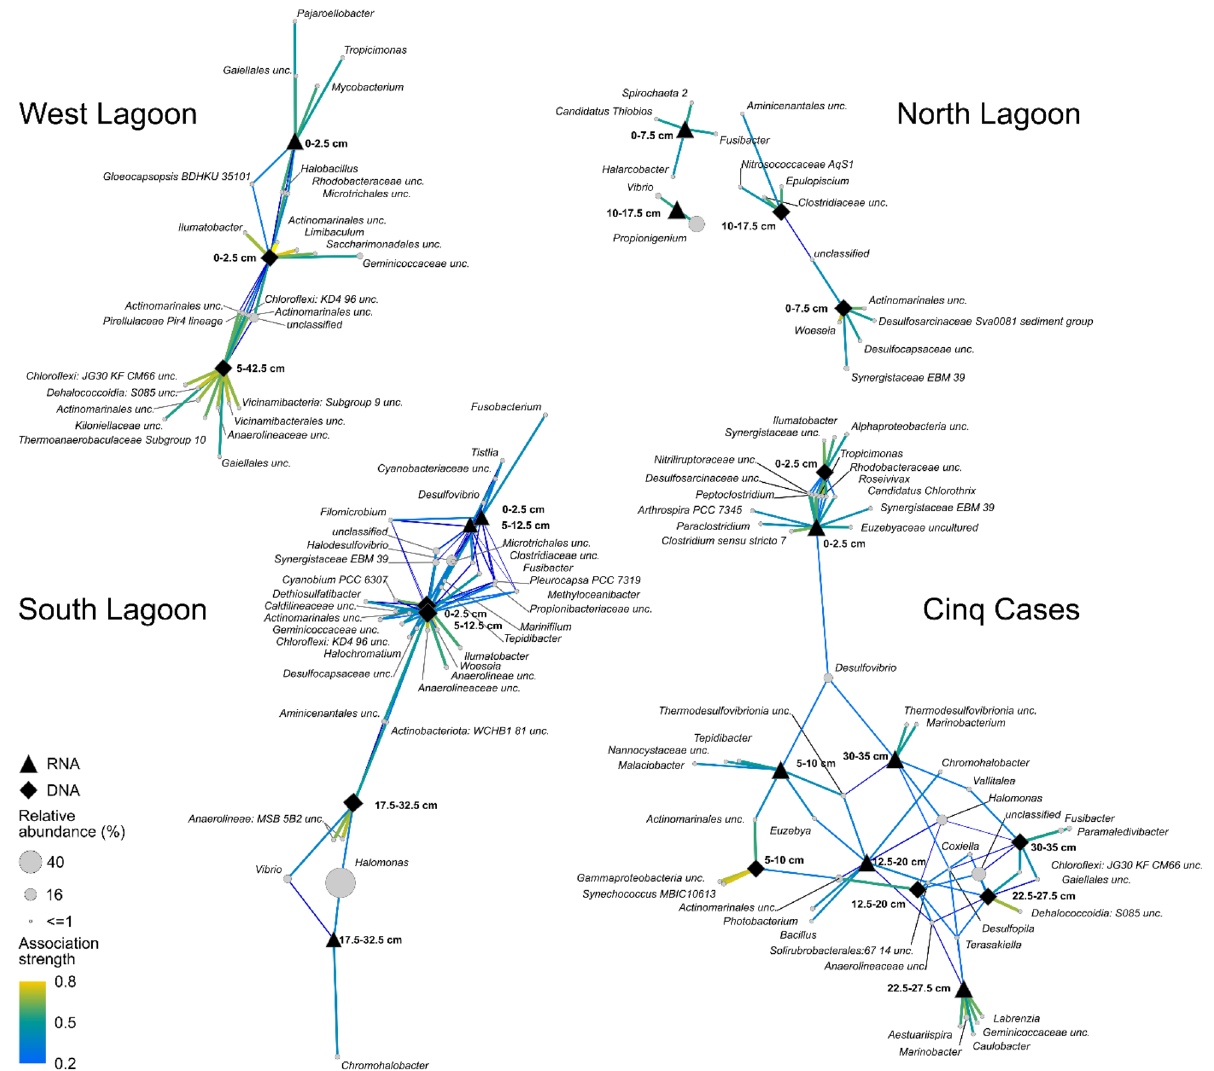
Figure 5. Genera associated with the total or active community fraction at each sampling site based on the geochemical zonation. The network was calculated using the multipatt analysis from the indicspecies package 88 . Circle sizes indicate the mean relative abundance between all samples. Edges are coloured according to their association strength to each target zone. Unclassified signifies ASVs which could not be taxonomically classified at genus